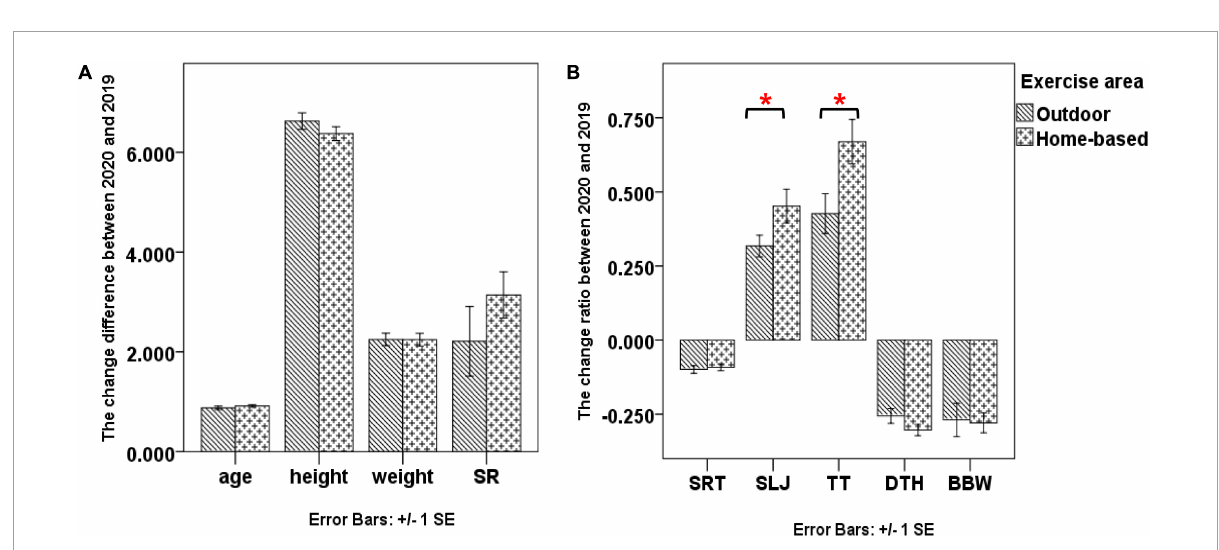
FIGURE3 The changes of demographic characteristics and all the NPFM outcomes between 2020 and 2019 for the children primarily participating in outdoor exercise and those participating in home-based exercise. (A) for the change differences of age, height, weight, and SR test; (B) for the change ratios of SRT, SLJ, TT, DTH, and BBW tests. SR, sit-and-reach; SRT, 10-m shuttle run test; SLJ, standing long jump; TT, tennis throwing; DTH, double-leg timed hop; BBW, balance beam walking. *Denotes p < 0.050.